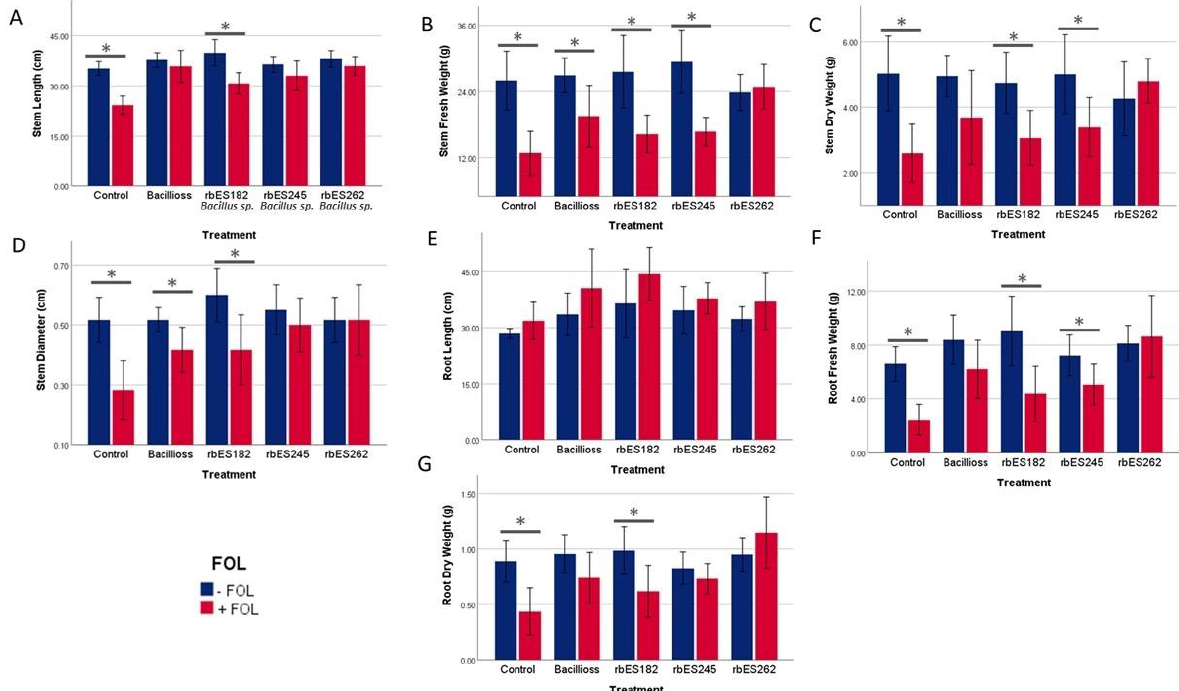
Figure 4. Effect of rhizobacteria inoculation on Fusarium wilt in tomato. Effect on stem length ( A ), stem fresh weight ( B ), stem dry weight ( C ), stem diameter ( D ), root length ( E ), root fres weight ( F ), and root dry weight ( G ) in plants treated with different rhizobacterial strains and inoculated (red bars) or not (blue bars) with F.oxysporum .Bars represent the mean of 8 plants ± SD per treatment. An asterisk over a pair of bars indicates significant differences ( p <